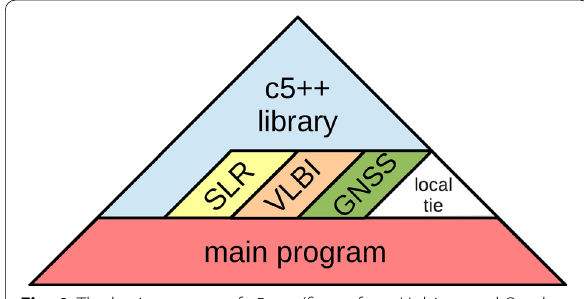
Fig. 4 The basic concept of c5 (figure from Hobiger and Otsubo ++ (2014)). The c5 analysis software allows for COL using common ++ geophysical models for all the supported space‑geodetic techniques, namely SLR, GNSS and VLBI